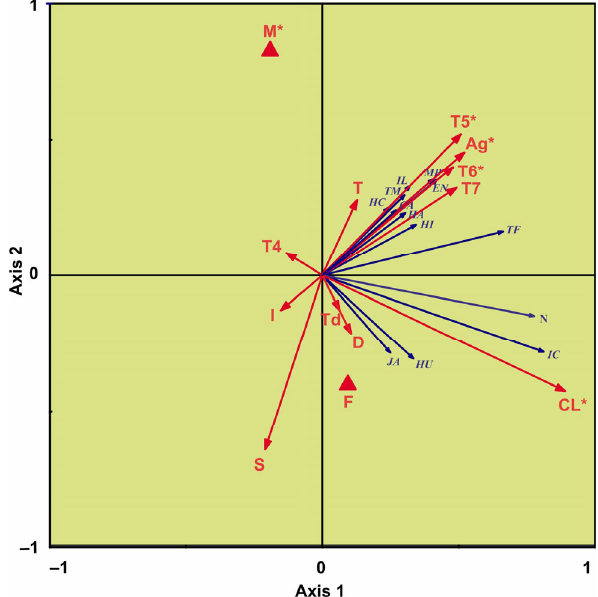
Figure 3. Redundancy analysis (RDA) biplot showing relationships between biotic variables (square-root-transformed intensity of common crab-associated organisms and total number of species per crab) and environmental variables. Abbreviations of biotic variables (blue arrows): CA— Circeis armoricana ,